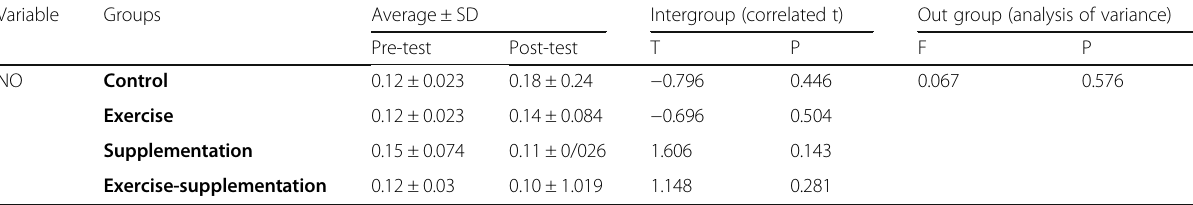
Table 4 The results of t-test and analysis of variance of synovial NO levels in post-test and pre-test groups